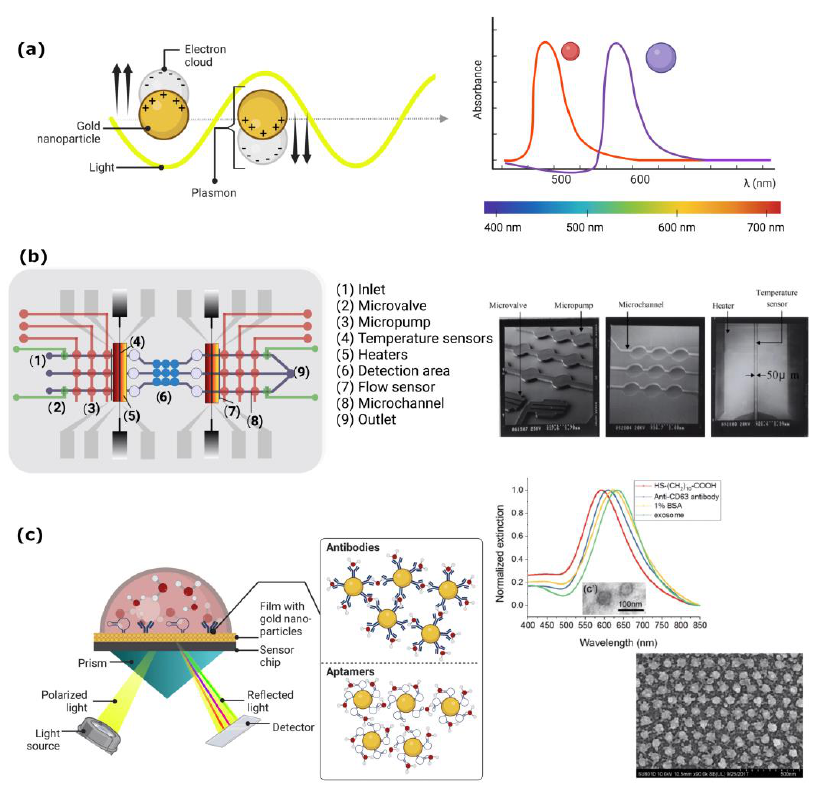
Figure 4. ( a ) Schematic configuration of a surface plasmon resonance biosensor. A visual representation of the electron cloud’s behavior in a thin gold film when stimulated by light, resulting in the surface plasmon effect, indicated by an absorption peak at a specific frequency that varies based on the size and shape of the nanoparticles. ( b ) This micrograph illustrates the different zones of Lee’s microfluidic channels (reproduced with permission) used for the operation of a lab-on-a-chip for immunoassays and detection of plasmonic signals [74]. ( c ) The presented scheme depicts the process occurring in the SPR sensor. Resonance produces an amplified increase in the extinction signal when gold nanoparticles bind to antibodies, enabling the detection of the immune signal that identifies the presence of cancerous cells in the sample. Adapted with permission from Ref. [75]. Copyright 2019 American Chemical Society. (Created with